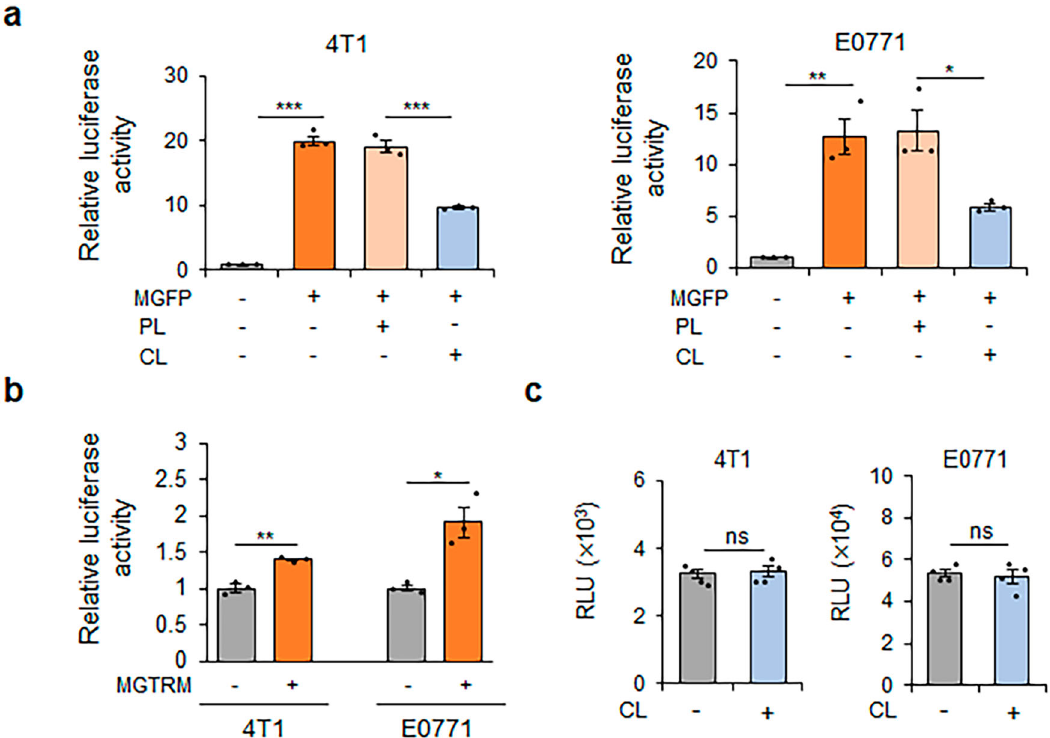
Fig. 2 TNBC proliferation is promoted by mammary gland fat pad (MGFP) and MGTRMs in vitro. a 4T1 and E0771 cells carrying luciferase reporter genes were co-cultured with MGFP treated with PBS liposomes (PL) or clodronate liposomes (CL) for 3 days. Luciferase activity of TNBC cells was normalized by the luciferase activity of corresponding monocultured TNBC cells. n = 3. * p < 0.05, ** p < 0.01, *** p < 0.001 ( t -test). b 4T1 and E0771 cells carrying luciferase reporter genes were co-cultured with MGTRMs for 3 days. Luciferase activity of TNBC cells was normalized by the luciferase activity of corresponding monocultured TNBC cells. n = 3. * p <0.05, ** p <0.01 ( t -test). c Luciferase activity of 4T1/Fluc and E0771/mKO2-luc2 cells cultured with ( + ) or without ( − ) CL for 3 days was measured and their relative light units (RLU) are shown. n = 4. ns not signi fi cant ( t -test). a – c Error bars indicate s.e.m.